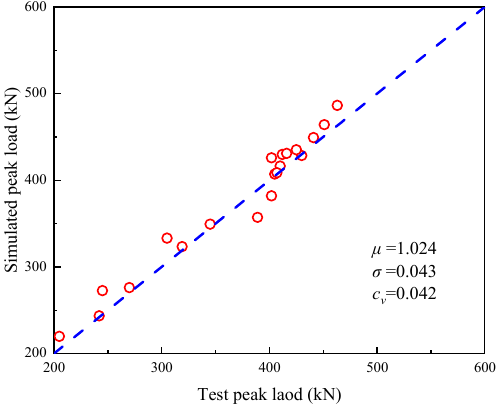
Figure 15. Comparison of peak load between test and simulation.